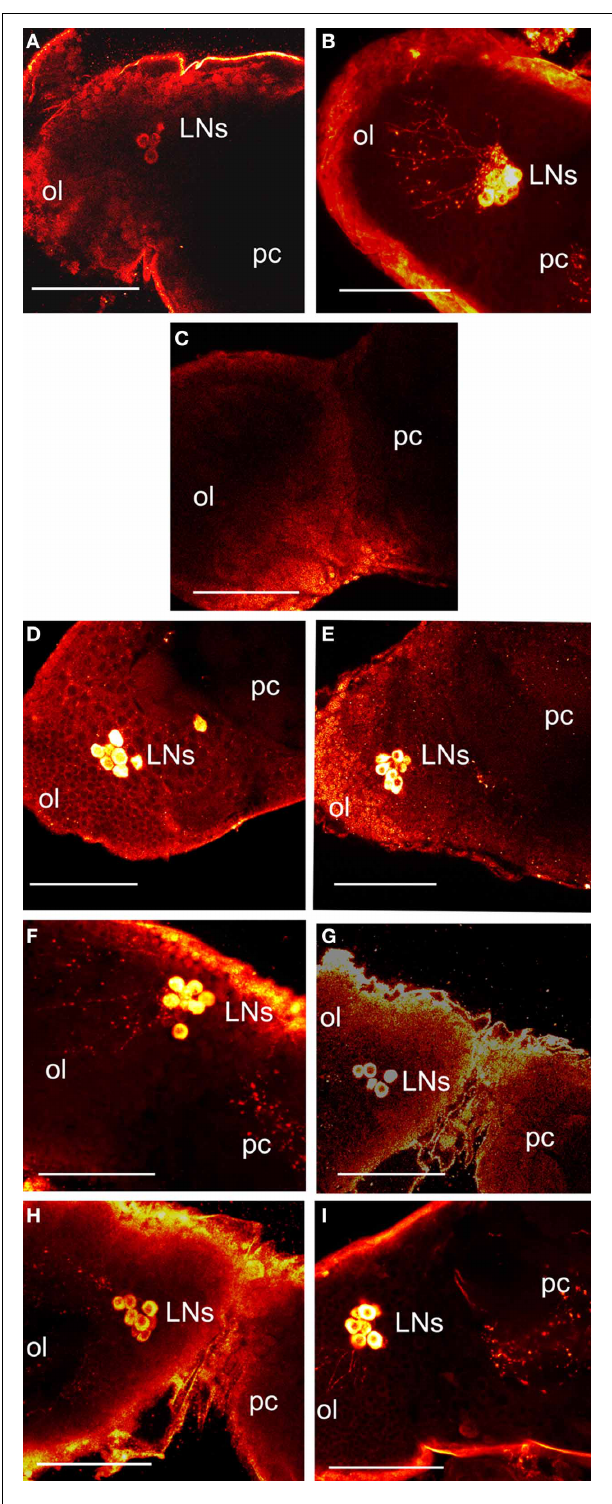
FIGURE 3 | Images of control and treated brains 12 days after a blood meal. All images are a dorsal view of the right brain hemisphere. (A–C) show in vivo brains. Control scotophase brains from entrained animals in 12L:12D stained with anti-PER (A) or anti-PDF (B) . Fluorescence is